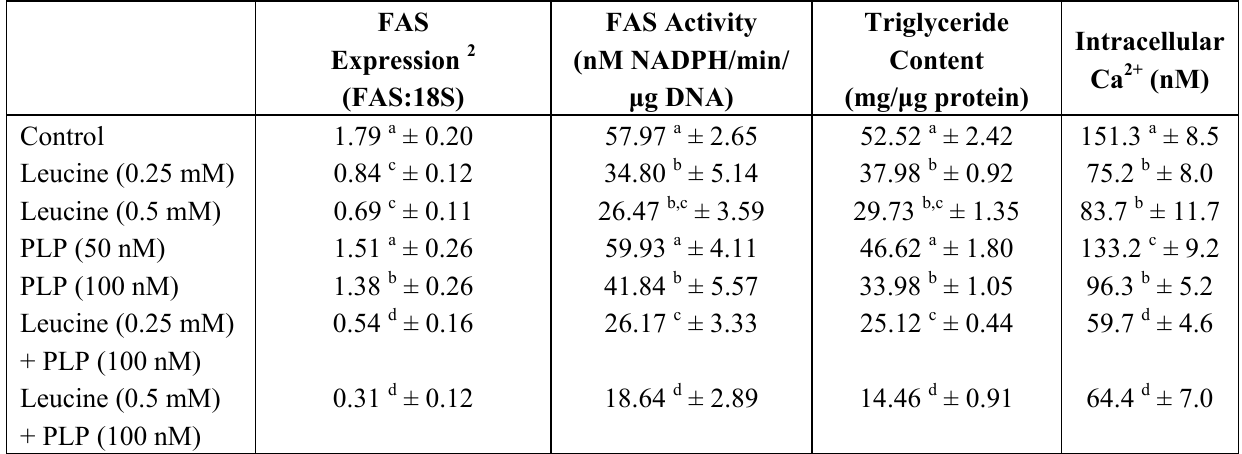
Table 1. The interactive effects of Pyridoxal Phosphate (PLP) and Leucine on adipocyte metabolism. Cultured 3T3L1 adipocytes were treated with PLP (50 or 100 nM) and